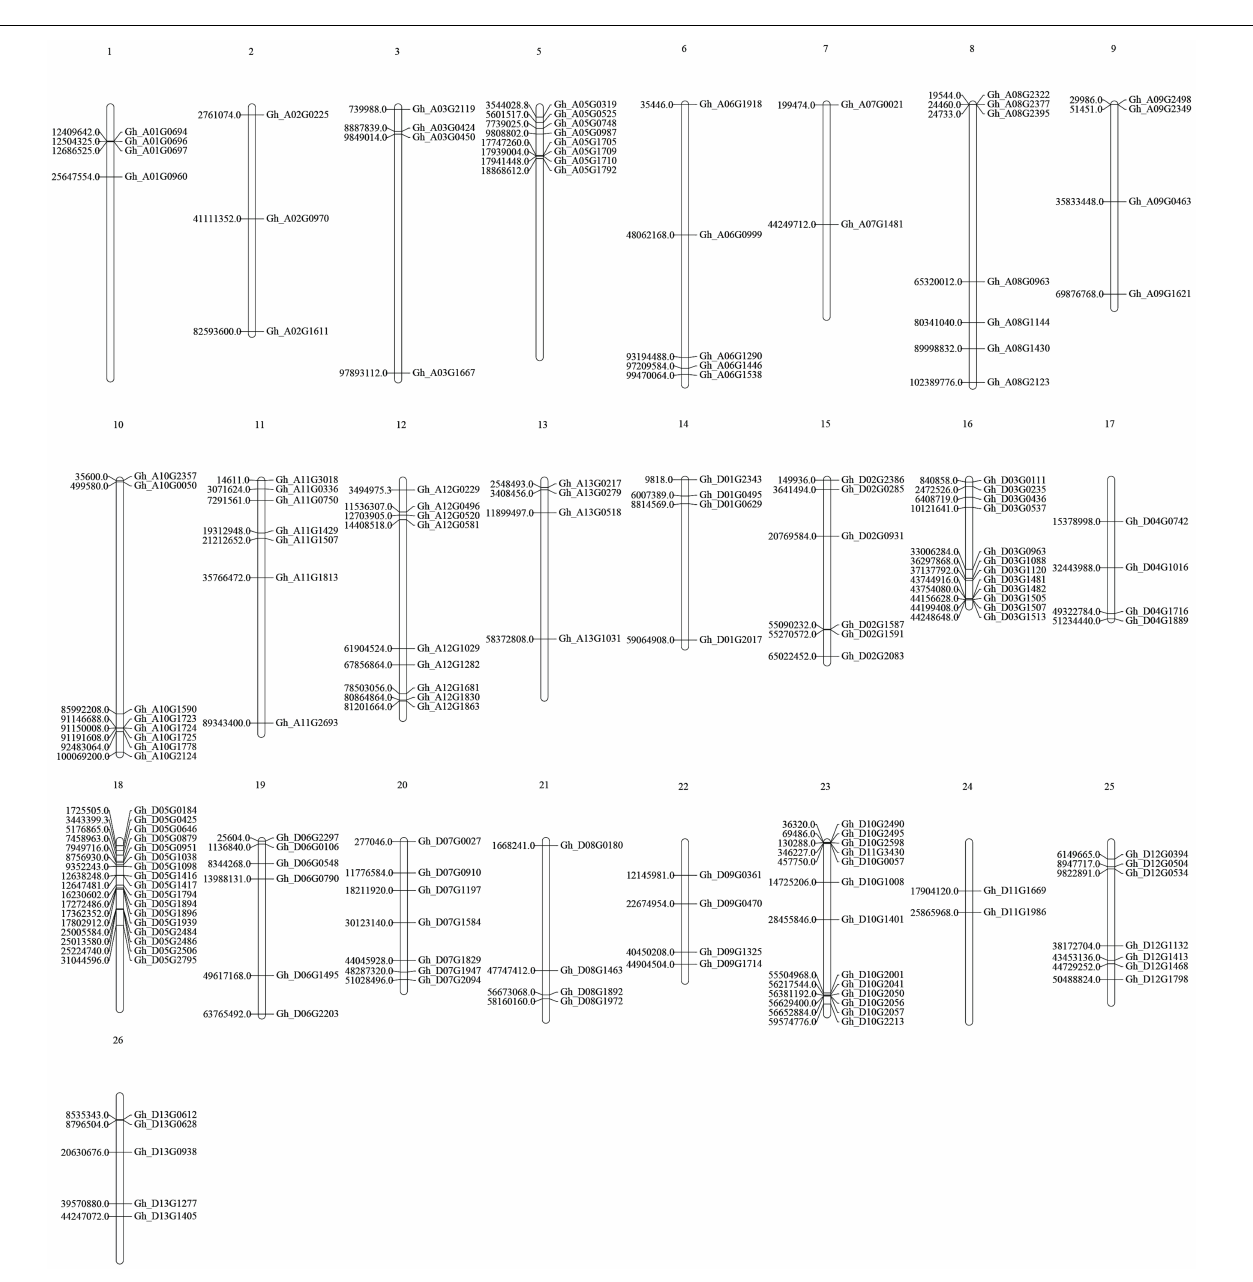
FIGURE 4 | Locations of the P450 genes on upland cotton chromosomes.